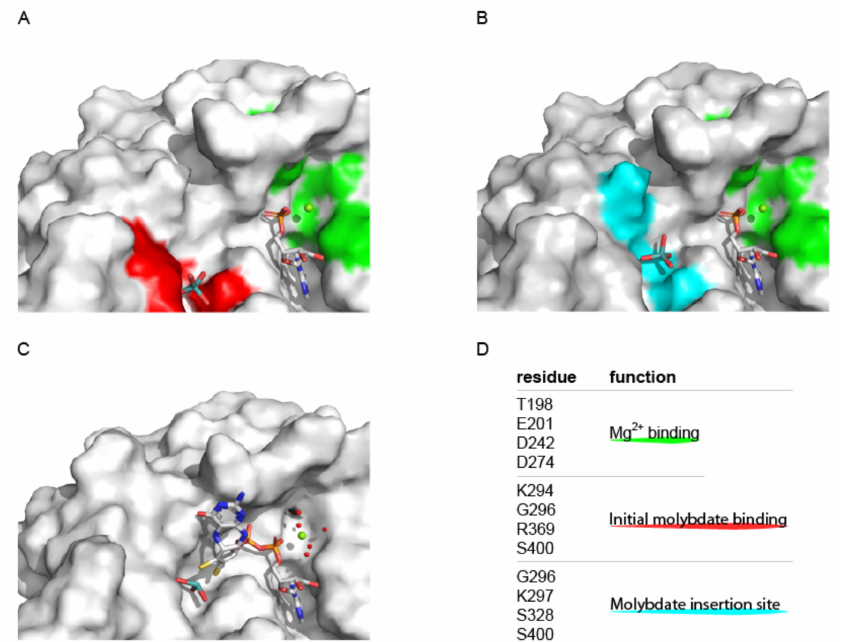
Figure 6. The 2021 model for molybdenum insertase functionality. ( A , B ) Active site view of the Cnx1 E-domain with bound AMP and molybdate in the initial binding site ( A ) and in the insertion site ( B ) (A and B: PDB entry: 6ETF, [26]). Monomer A is shown in surface representation. The residues tabulated in ( D ) are colored as indicated. ( C ) Active site view of the Cnx1 E-domain with bound Moco-AMP (termed adenylated Moco, PDB entry: 6Q32, [14]). ( A , B ) AMP, molybdate and Moco-AMP ( C ) are shown in stick notation. Atoms are colored as follows: carbon, grey; oxygen, red; nitrogen, blue; phosphorous, orange; sulfur, yellow; cupper brown. Hydrogen atoms are omitted. The active site Mg 2+ ions are shown as green spheres. ( D ) Catalytically relevant residues identified for the Cnx1 E-domain and their proposed functions [14,26,47] are tabulated. Figure panels A – C were created with PyMOL